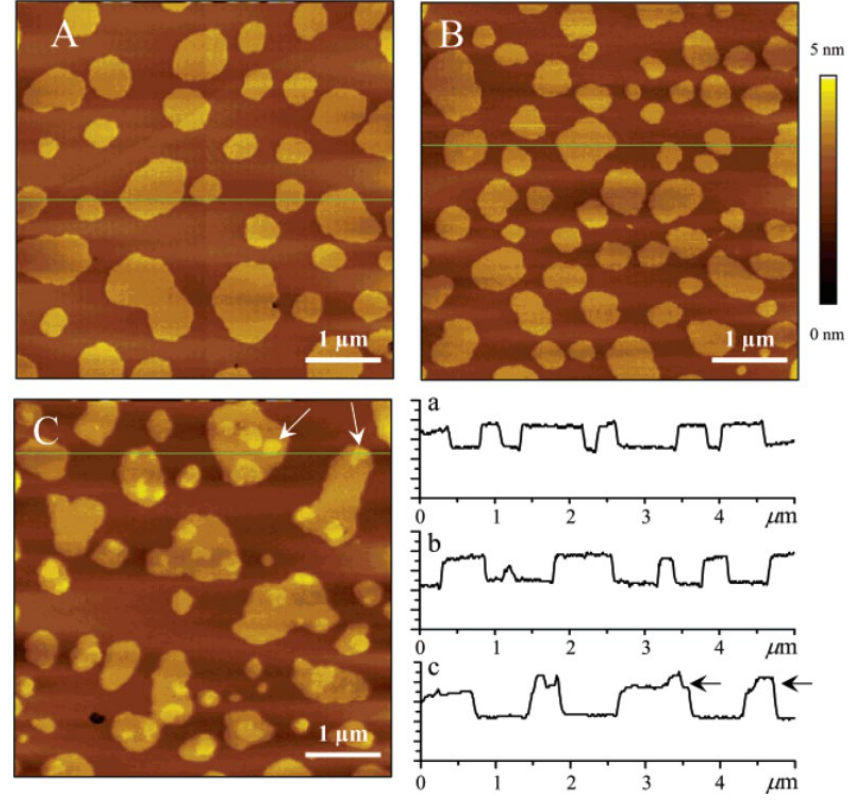
Figure 4. AFM images of C16:0SM/Chol/DOPC (2:1:2 molar ratio) bilayers containing 0 ( A ), 5 ( B ), and 10 ( C ) mol % of C16:0Cer. The total mole percentage of SM plus ceramide was kept constant at 40%. All images are 5 × 5 μm with a z-scale of 5 nm. Cross-sections for lines indicated in images ( A – C ) are shown in a, b, and c, respectively. The Lo domains showed higher membrane thickness while the Ld domains showed lower. Thus, the brighter and darker regions correspond to the Lo and Ld domains, respectively, in these AFM images. Some examples of the convex subdomains for 10% ceramide are indicated by arrows in image C and cross-section c. This figure was adapted with permission from [61]. Copyright 2006 American Chemical Society.